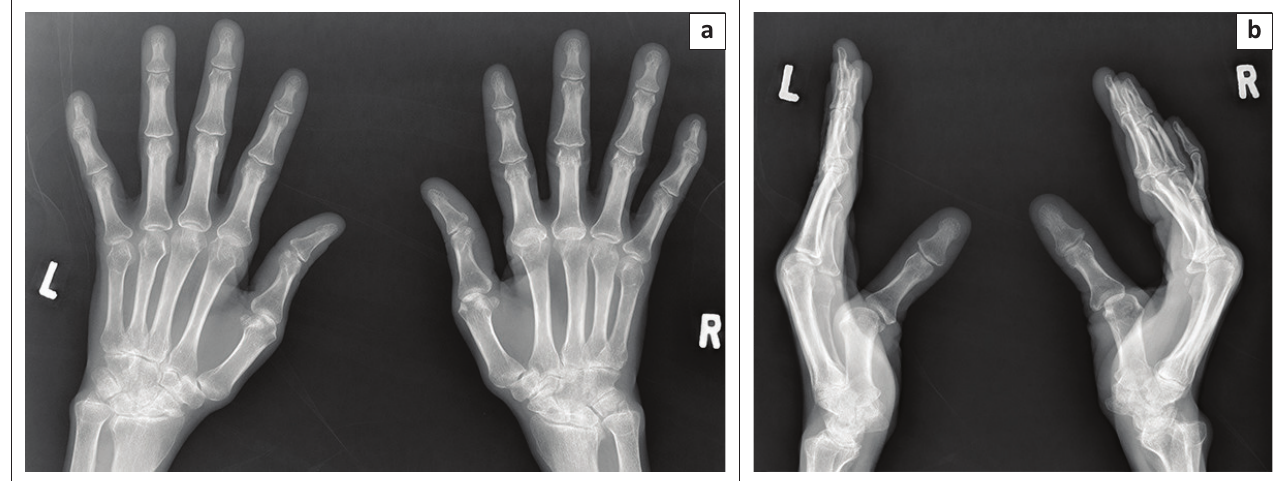
FIGURE 4: (a) Frontal and (b) lateral radiographs of both hands of an HIV-positive patient presenting clinically with reducible deformities and arthralgia. Rheumatoid factor and anti-nuclear factor were negative. Lateral radiographs show subluxations at the metacarpophalangeal joints bilaterally as well as the distal interphalangeal joints of both 5th fingers. The right hand is more affected than the left, with the left hand demonstrating more reducible deformities on the frontal radiograph compared to the right hand.